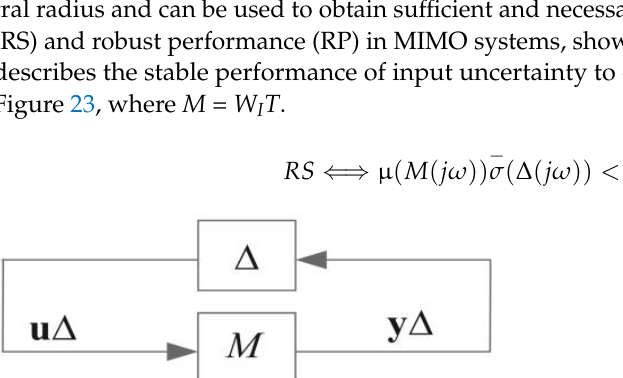
Figure 22. Complementary sensitivity curves.